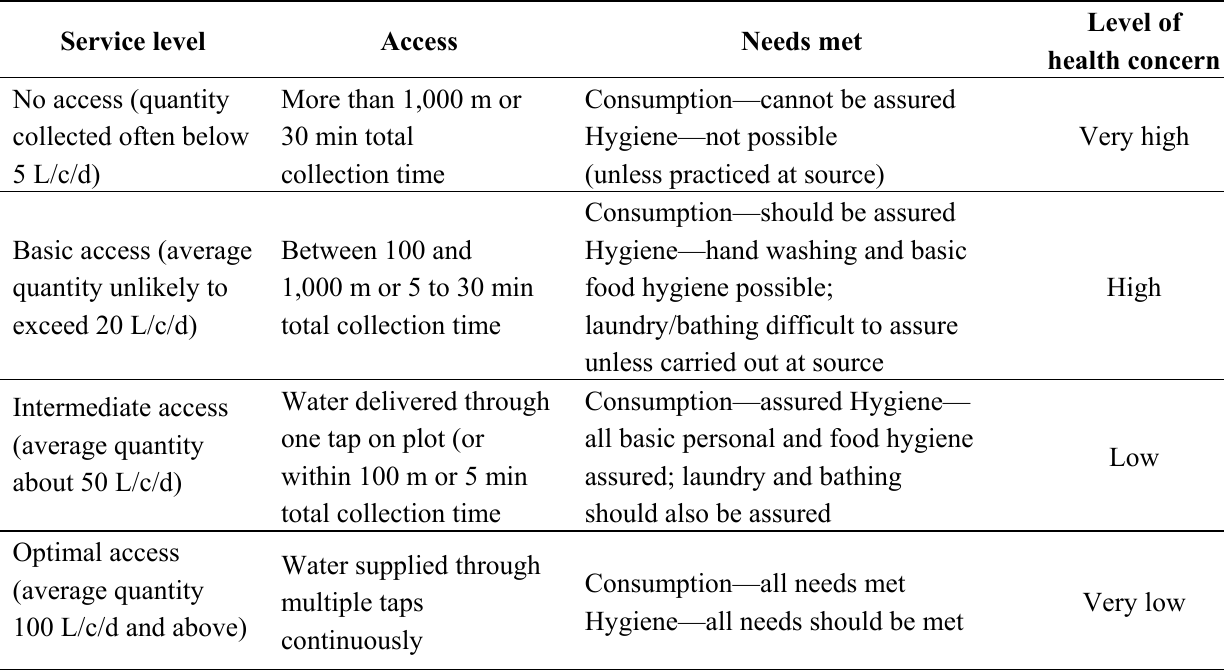
Table 1. Water service levels (Reprinted from [9] with